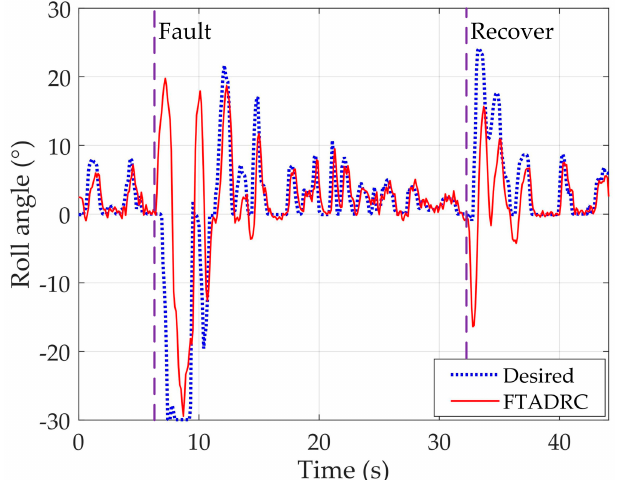
Figure 24. Curves of roll angle. Electronics 2018 , 7 , x FOR PEER REVIEW